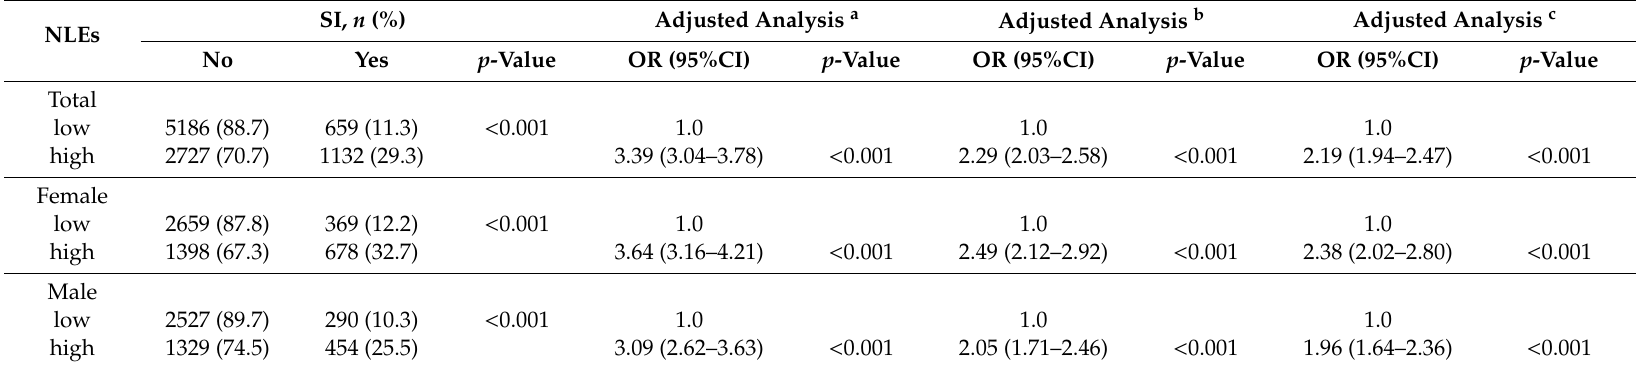
Table 2. Number, % and adjusted odds ratio (OR) of SI by level of NLE: 15-school study,